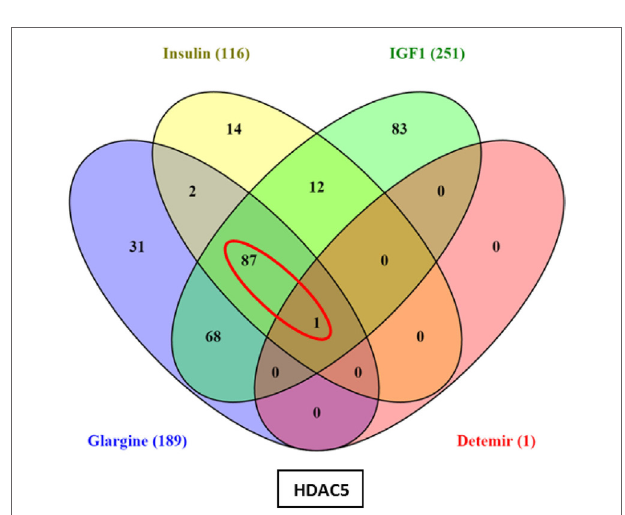
FigUre 2 | Venn diagram: differentially expressed genes in ECC-1 cells after ligands treatment. The diagram displays all possible logical relations between the differential gene expression sets for each treatment in ECC-1 cells. Only one gene (HDAC5) was differentially expressed after detemir treatment (shown in box). FC = 1.5 and pFDR <